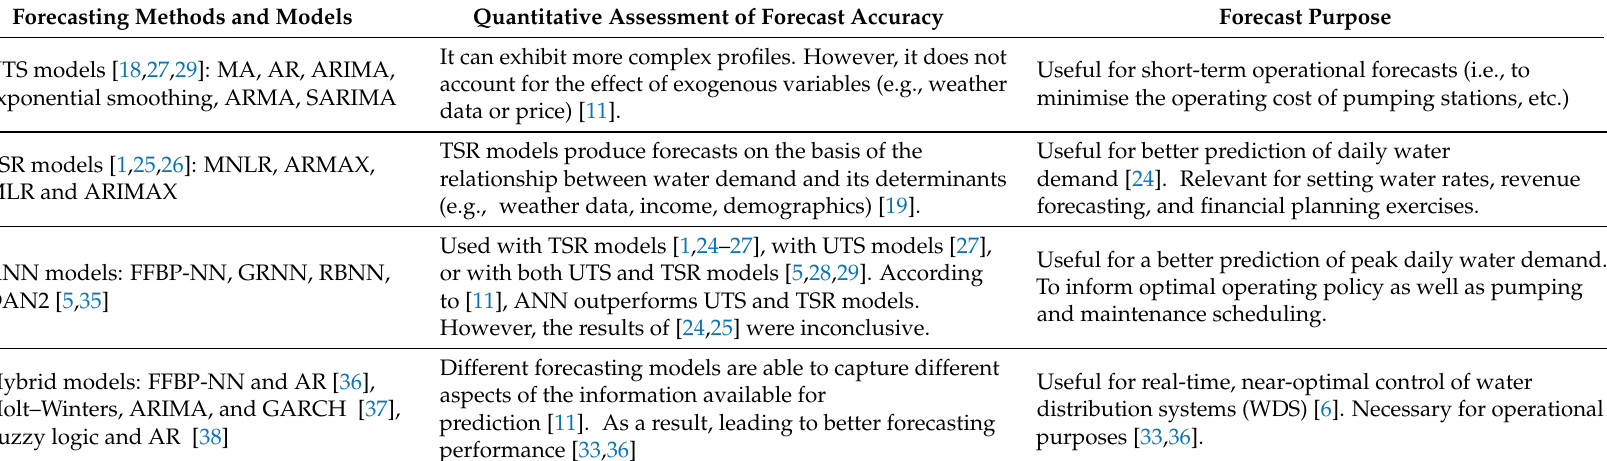
Table 1. Brief summary of short-term water demand (STWD) forecasting methods and models. UTS: univariate time series; MA: moving average; AR: